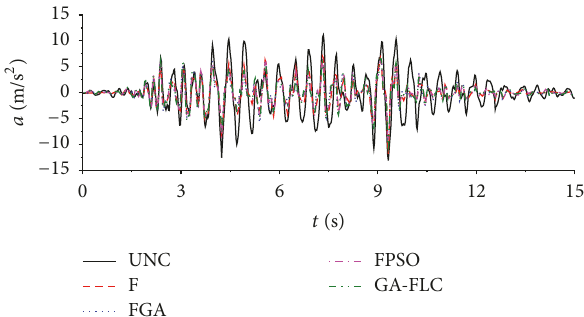
Figure 20: Top-layer acceleration response curve under the action of the Nanjing wave.